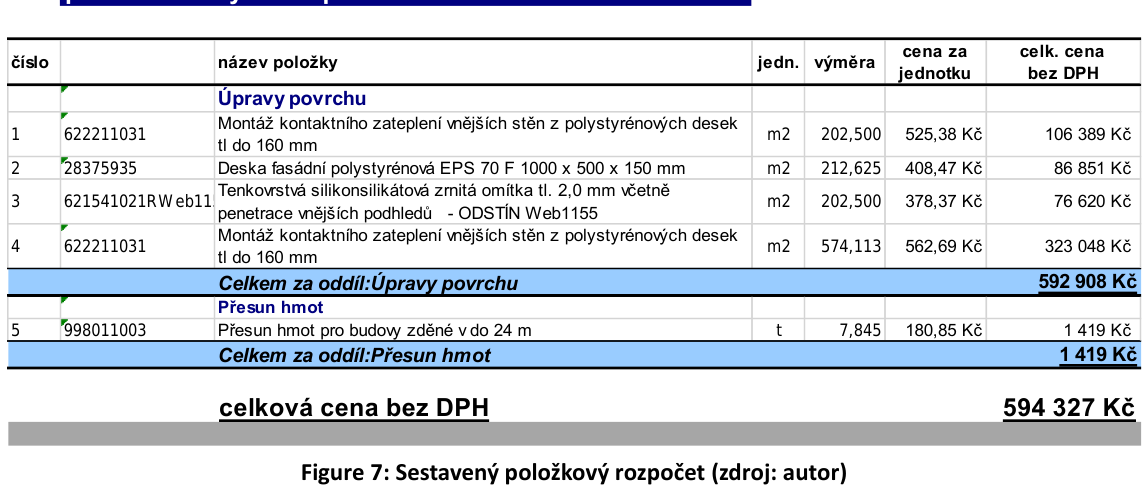
Figure 7: Sestavený položkový rozpočet (zdroj: